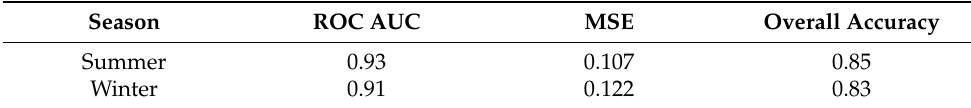
Table 5. ROC AUC, MSE, and overall accuracy performance indicators are listed for the Summer and Winter wildfire models,